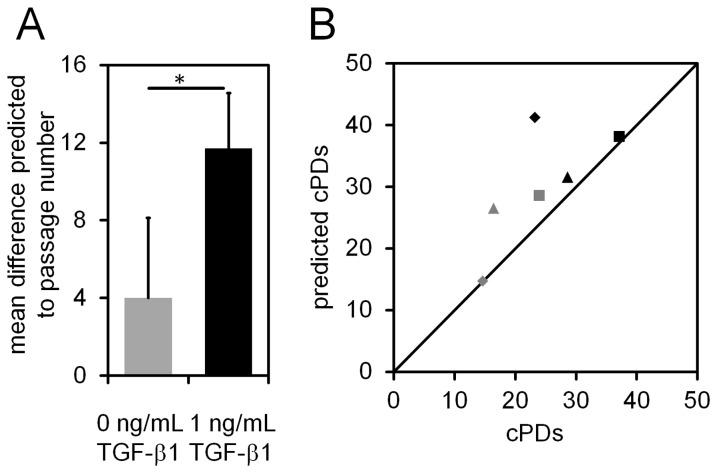
Effect of TGF-β1 on senescence-associated DNA-methylation signature.MSCs were cultured for three passages either with or without TGF-β1. Then the state of cellular senescence was tracked using our recently described Epigenetic-Senescence-Signature which is based on DNA-methylation (DNAm) changes at six specific CpG sites in the genome [35,36]. Predicted passage numbers and real passage numbers correlated well for controls, whereas the passage number was significantly overestimated for TGF-β1 treated cells (A; *p < 0.05). Comparison of predicted and real cumulative population doublings (cPDs) reflected the proliferative advantage with TGF-β1. Overall, the number of cPDs was slightly overestimated by the Epigenetic-Aging-Signature but this cannot be attributed to TGF-β1 stimulation (B). Symbols represent different MSC preparations that were cultured with (black color) or without TGF-β1 (grey color).